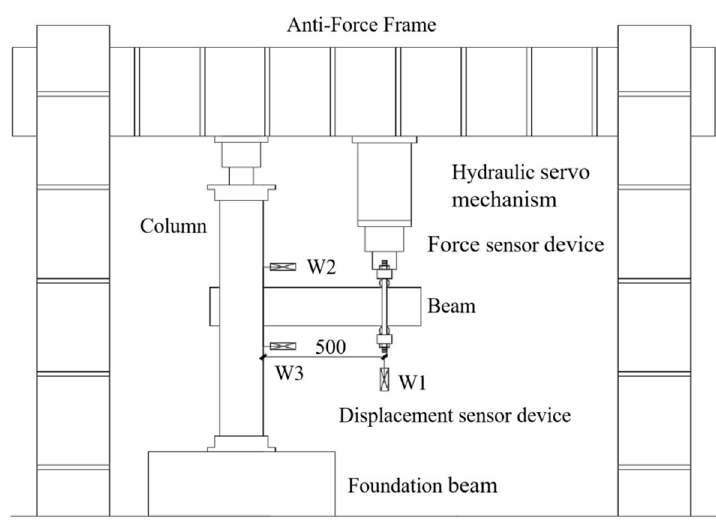
Figure 5. Pseudo-static test on loading devices.